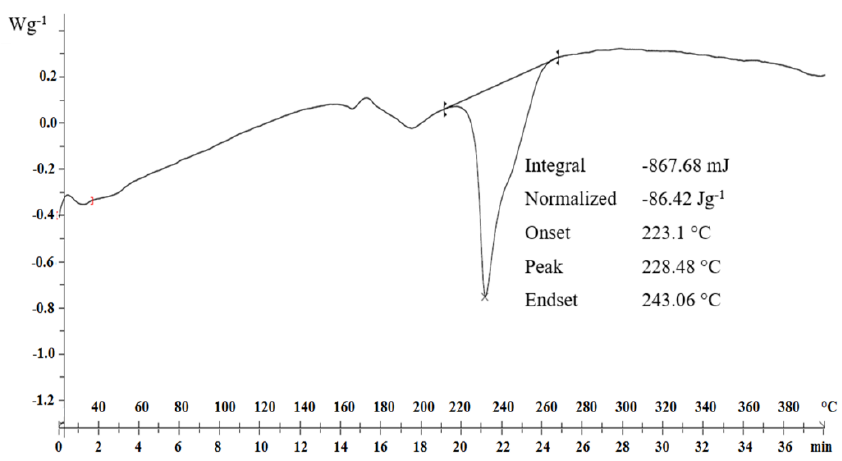
Figure 10. DSC curve for products crystallized from NO x gases in Test A.